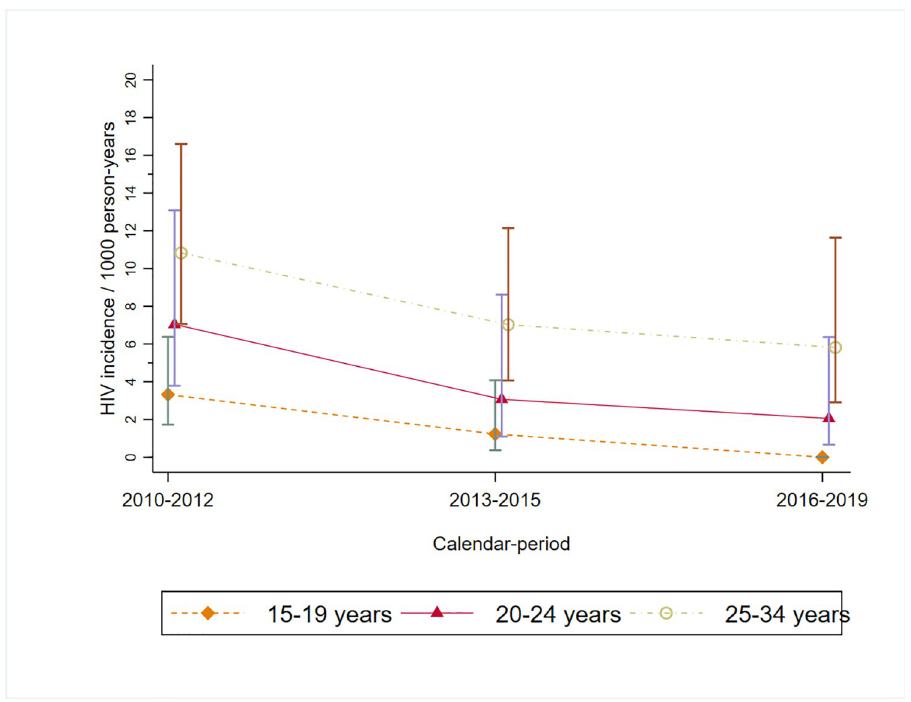
Fig 4. HIV incidence rates over time among young men with 95% CIs, in Gem, Kenya. CI, confidence interval.